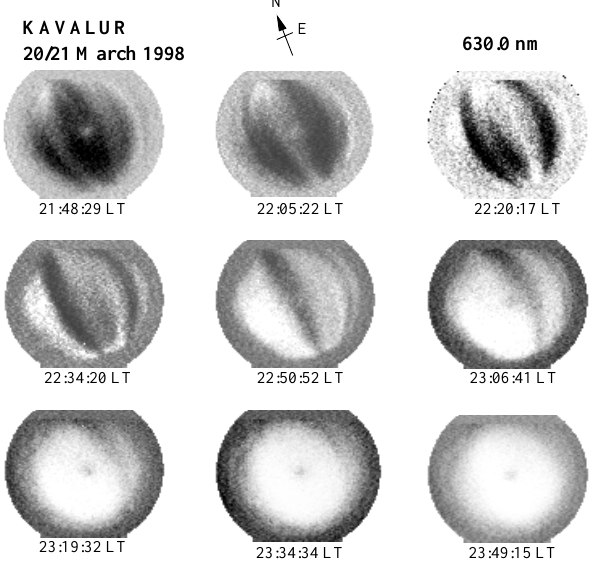
Fig. 5. Plasma depletions in the 630nm images taken over Kavalur on the night of 20/21 March 1998. The arrow points towards the geomagnetic north.